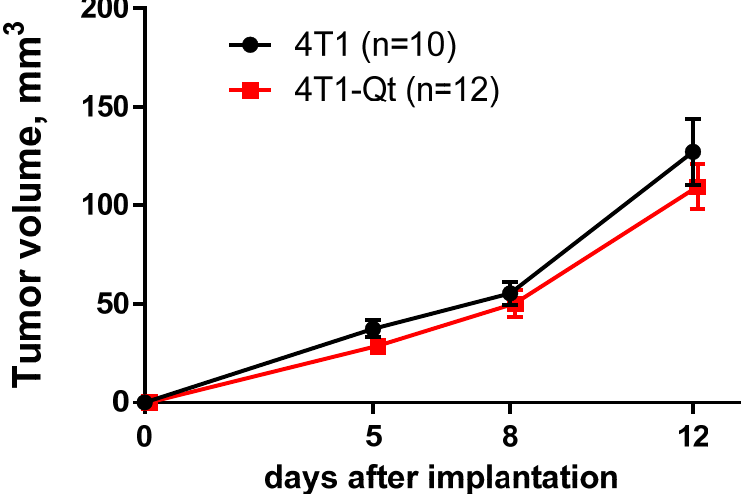
Figure 8. Tumor growth dynamics after subcutaneous implantation of wild-type 4T1 and 4T1-Qt cells. The data are shown as the mean + S.E.M.